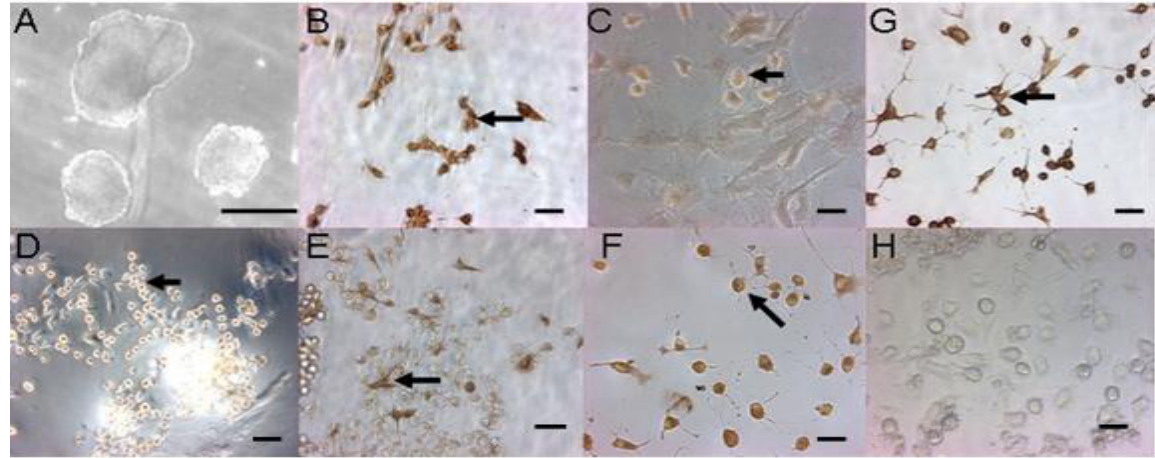
Figure 4. Immunohistochemical analysis of the differentiated cell produced from the ES cell-derived embryoid bodies. The ES cell clumps formed the EBs ( A ) in the leukemia inhibitory factor (LIF)- and feeder- free condition by suspension; and differentiated into cardiomyocytes positive for α-Actin ( B ) and osteoblasts ( C ) positive for Alizarin Red staining from the mesoderm, hepatic cells ( D ) positive for AFP from the endoderm, and neurocytes positive for Nestin ( E ); GFAP ( F ) and β-tubulin III ( G ) from the ectoderm; ( H ) was stained only by the secondary antibody as negative control. Scale bar = 50 μm. In ( B – G ), what the arrows indicated were the positive cells stained for the primary antibodies or the dye Alizarin Red, respectively. The arrows in Figure B – G , indicated the differentiated cells mentioned